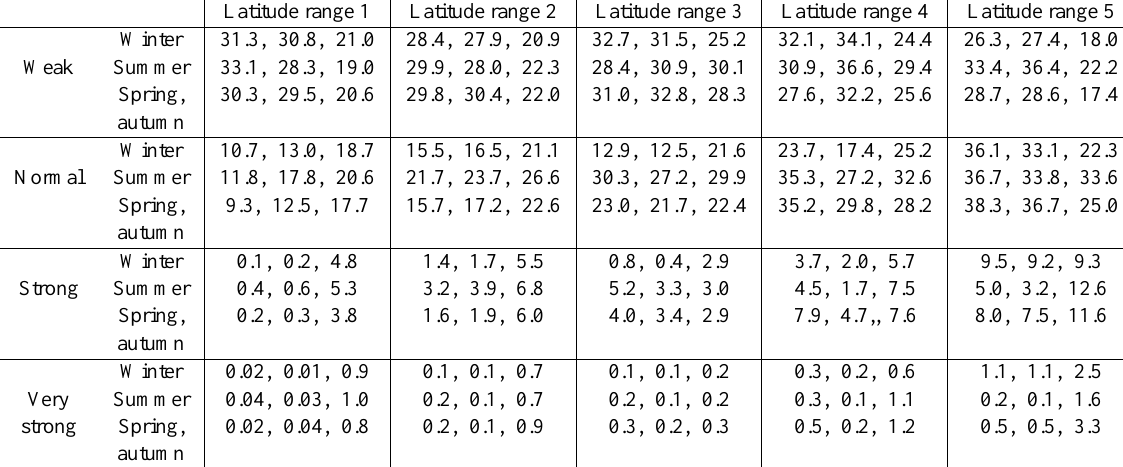
Table 2. Average values of weak, normal, strong, and very strong Nm F2 negative disturbance percentage occurrence in latitude ranges 1–5 during the winter, summer, and spring and autumn months for the first (first number) and second (second number) half of a day for χ ≤ 90 ◦ , and during the night-time period for χ > 90 ◦ (third